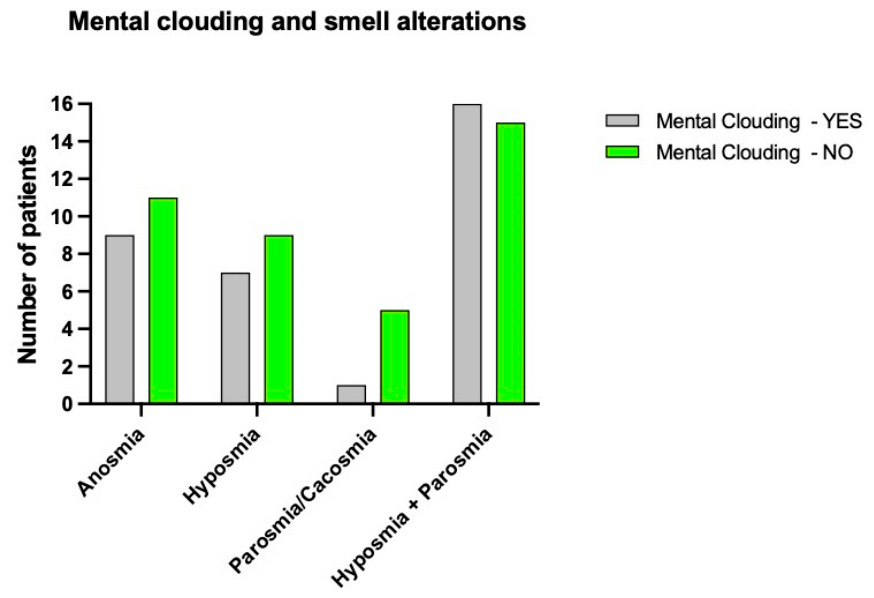
Figure 3. Distribution of mental clouding (brain fog) (presence and absence) relative to the different smell alterations.